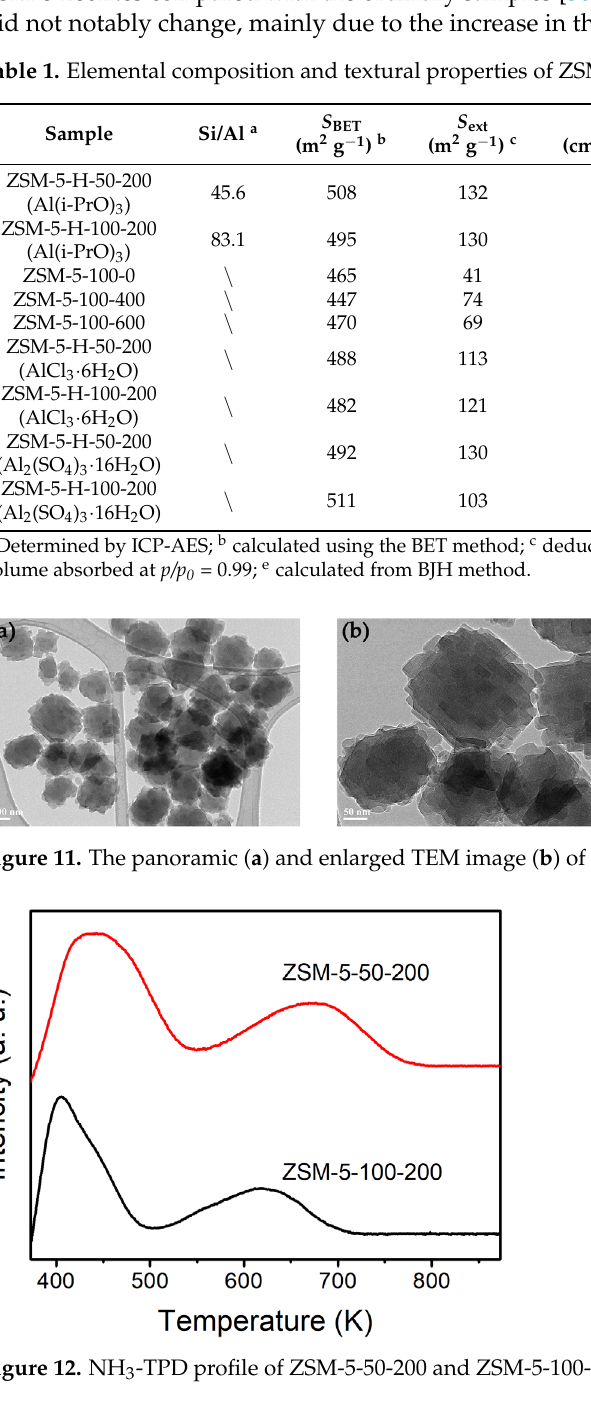
Table 1. Elemental composition and textural properties of ZSM-5-50-200 and ZSM-5-100-200. Sample Figure 9. XRD patterns ( a ) and FE ‐ SEM micrographs ( b , c ) of ZSM ‐ 5 ‐ 100 ‐ 200 synthesized with silica sol.